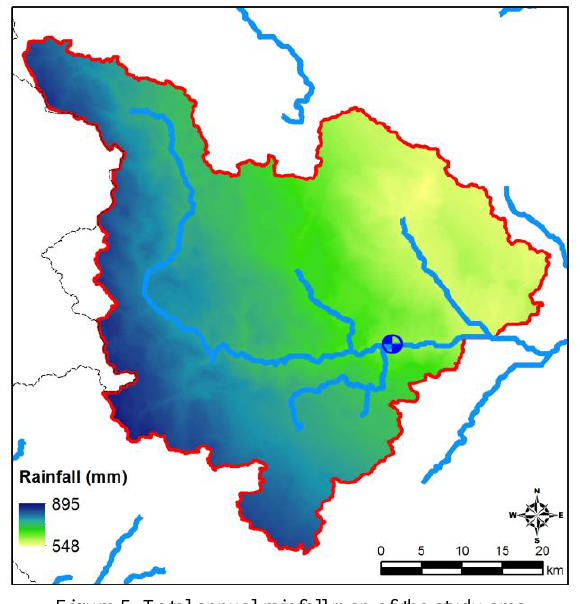
Figure 5. Total annual rainfall map of the study area